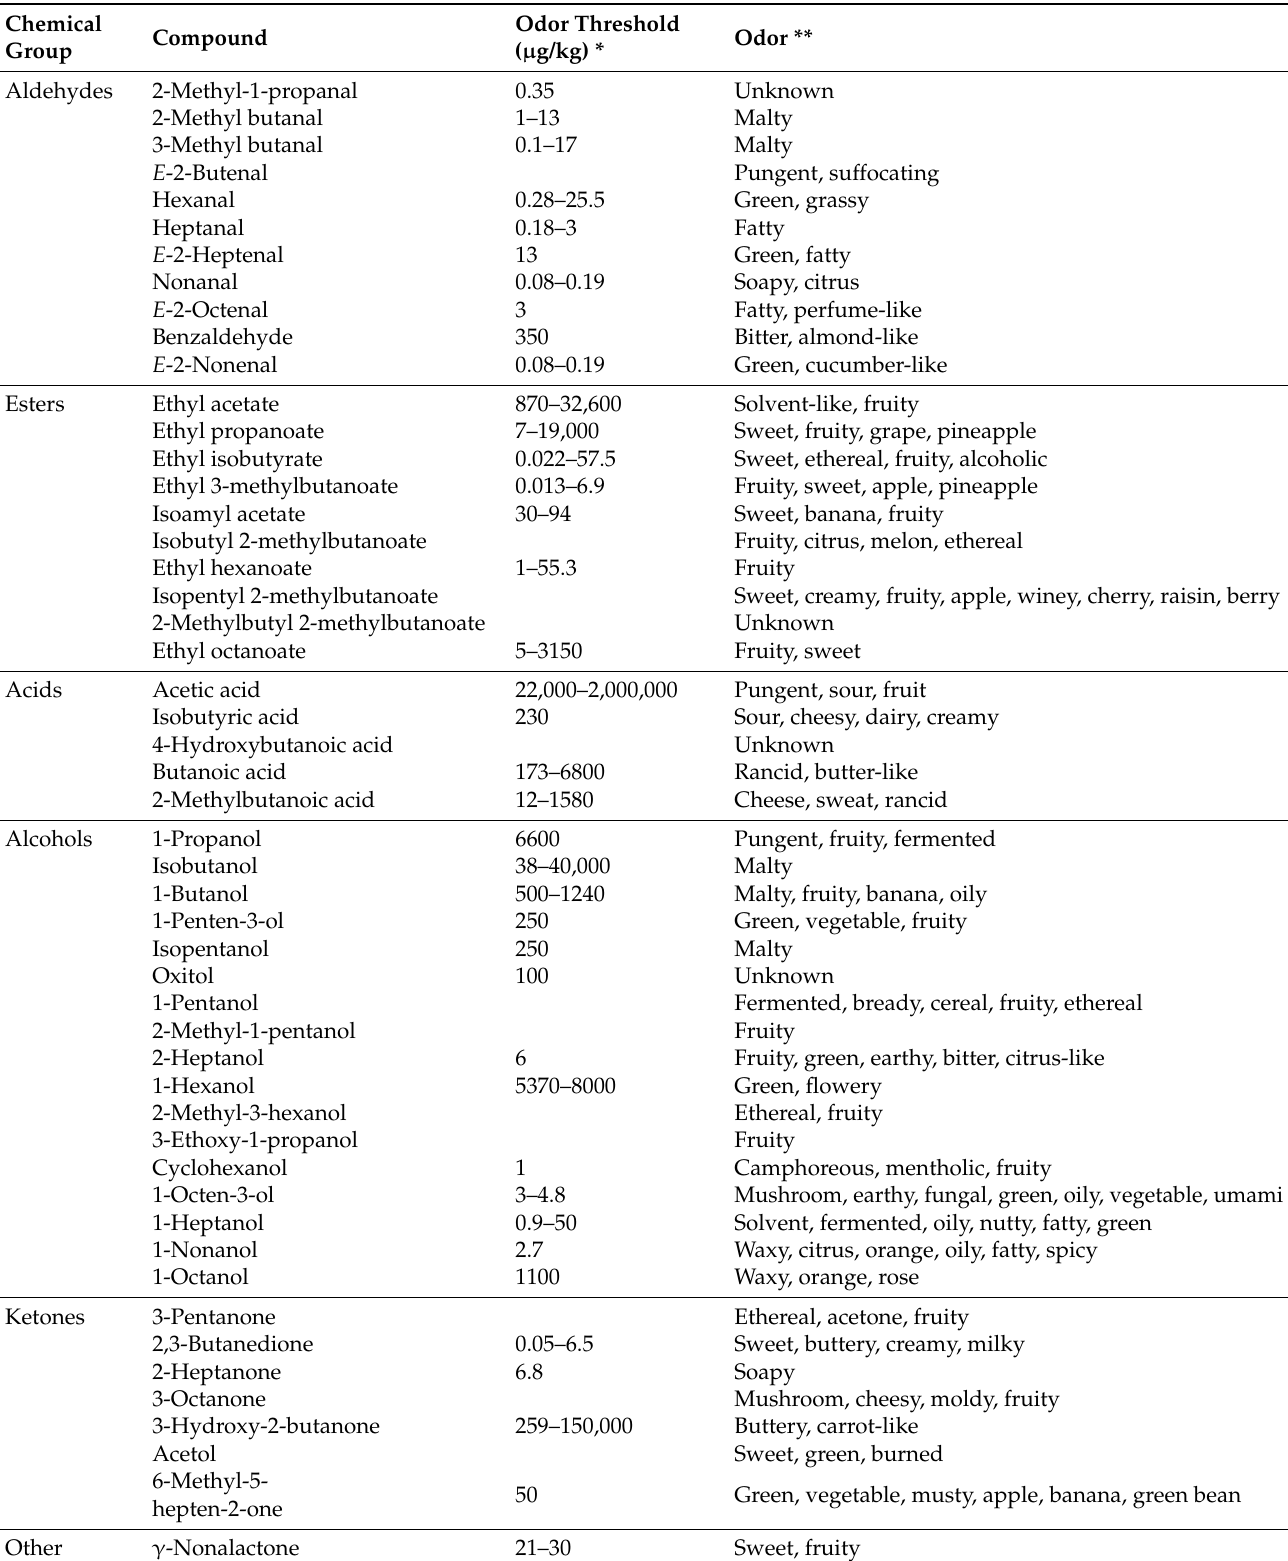
Table 4. A total of 51 identified volatile compounds and their odor threshold value and odor analyzed with GC-MS in dough fermented with 23 different yeast